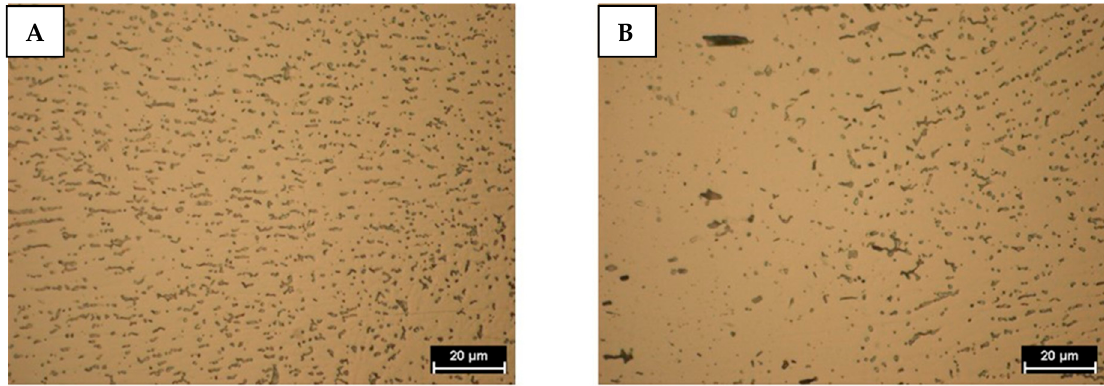
Figure 6. Aluminium microstructure in the fused zone ( A ) and fused/heat affected transition zone ( B ). Vickers microhardness profiles (0.3/15 s) were collected using a Vickers Affri Wiky 200JS2 microhardness tester (OM, Nikon, Tokyo, Japan) at half of weld cross section thickness. Distance between indentations was equal to 300 µ